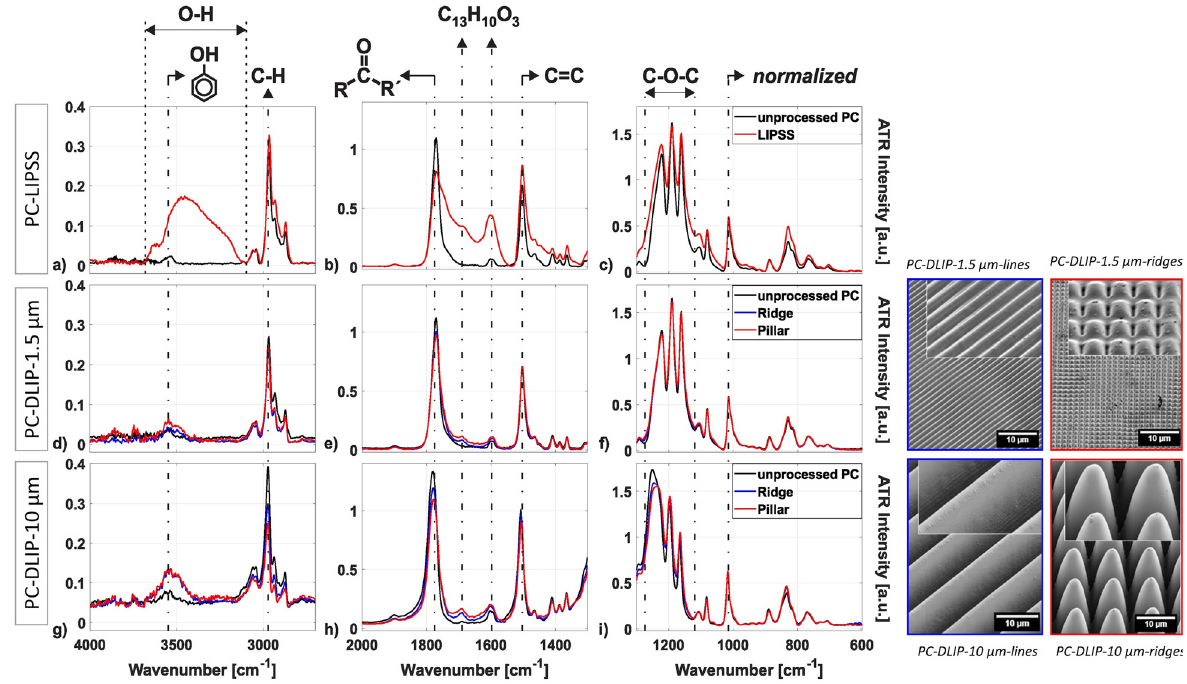
Figure 7: ATR-FTIR spectra of unprocessed PC (black curves) overlay with processed by (a) – (c) LIPSS (PC-LIPSS, red curves in and (d) – (f) PC-DLIP-1.5µmridge-like (bluecurves)orpillar-like(redcurves)and(g) – (i)PC-DLIP-1.5µmridge-like(bluecurves)orpillar-like(redcurves):In the left the corresponding SEM images. Figures reproduced from. Ref. [94] (Licensed under a Creative Commons